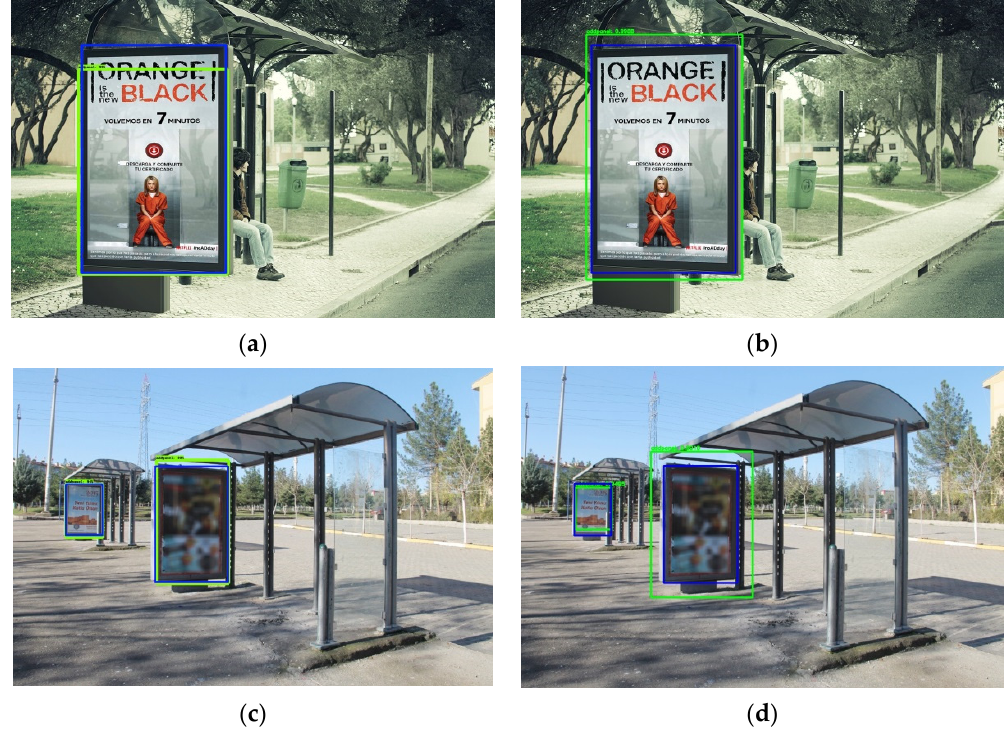
Figure 10. Qualitative detection results for two sample test images using SSD and YOLOv3: ( a ) SSD detection in first image; ( b ) YOLOv3 detection in first image; ( c ) SSD detection in second image; ( d ) YOLOv3 detection in second image.